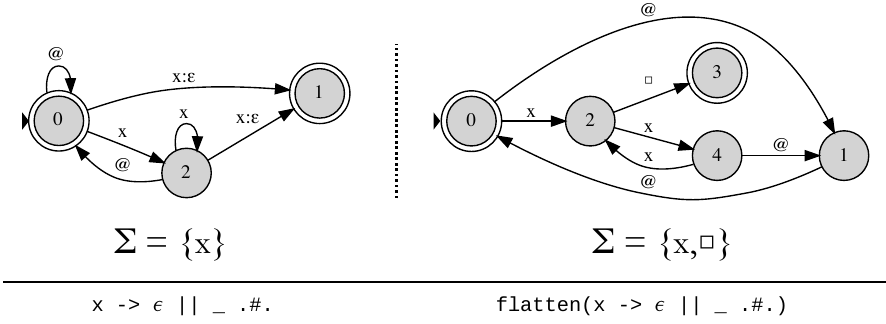
Figure 1: Illustration of a replacement-rule encoded as a transducer (left) and